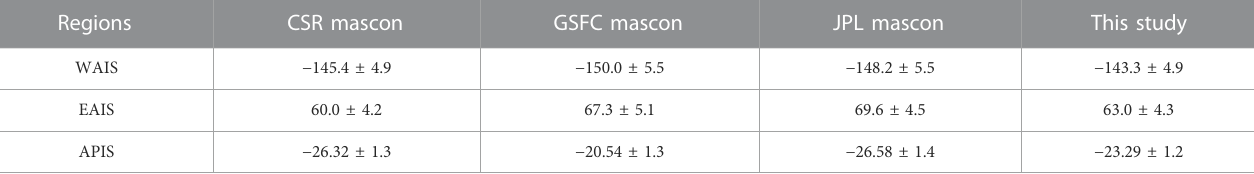
TABLE 6 Mass change rate from April 2002 to December 2016.